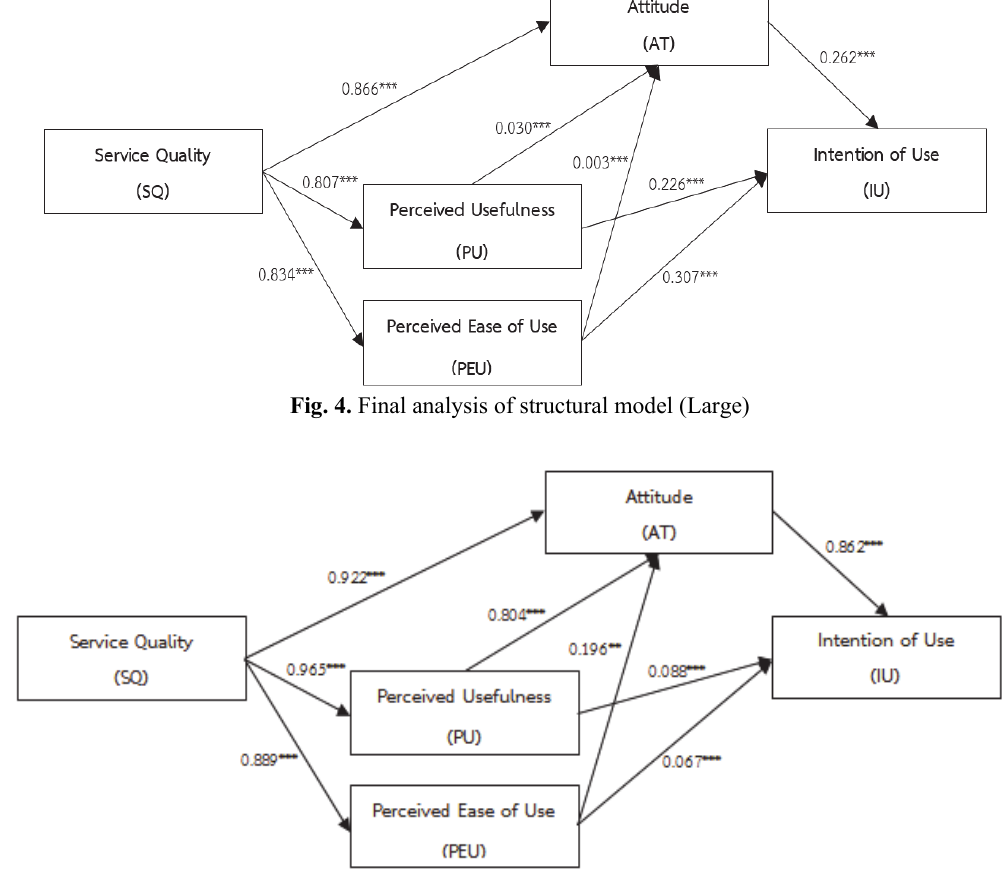
Fig. 5. Final analysis of structural model (Small) The results of hypotheses